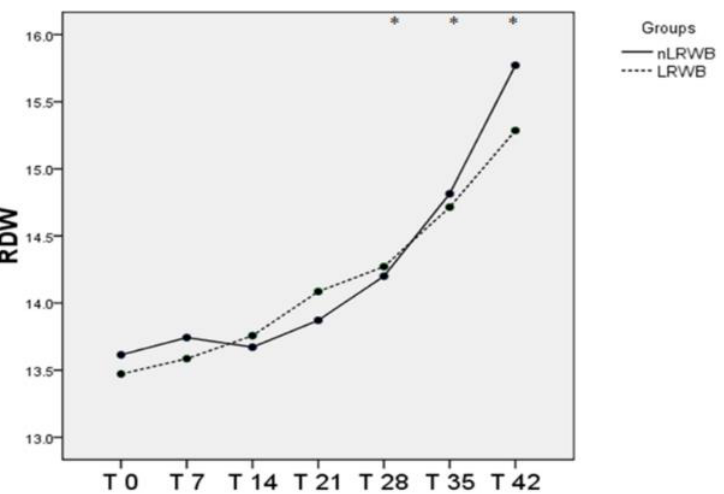
Figure 4. Differences in RDW (mean) measured in nLRWB and LRWB units during the storage period. The days of storage are presented in the x-axis. RDW (%) is presented in the y-axis. Asterisks * p < 0.05.